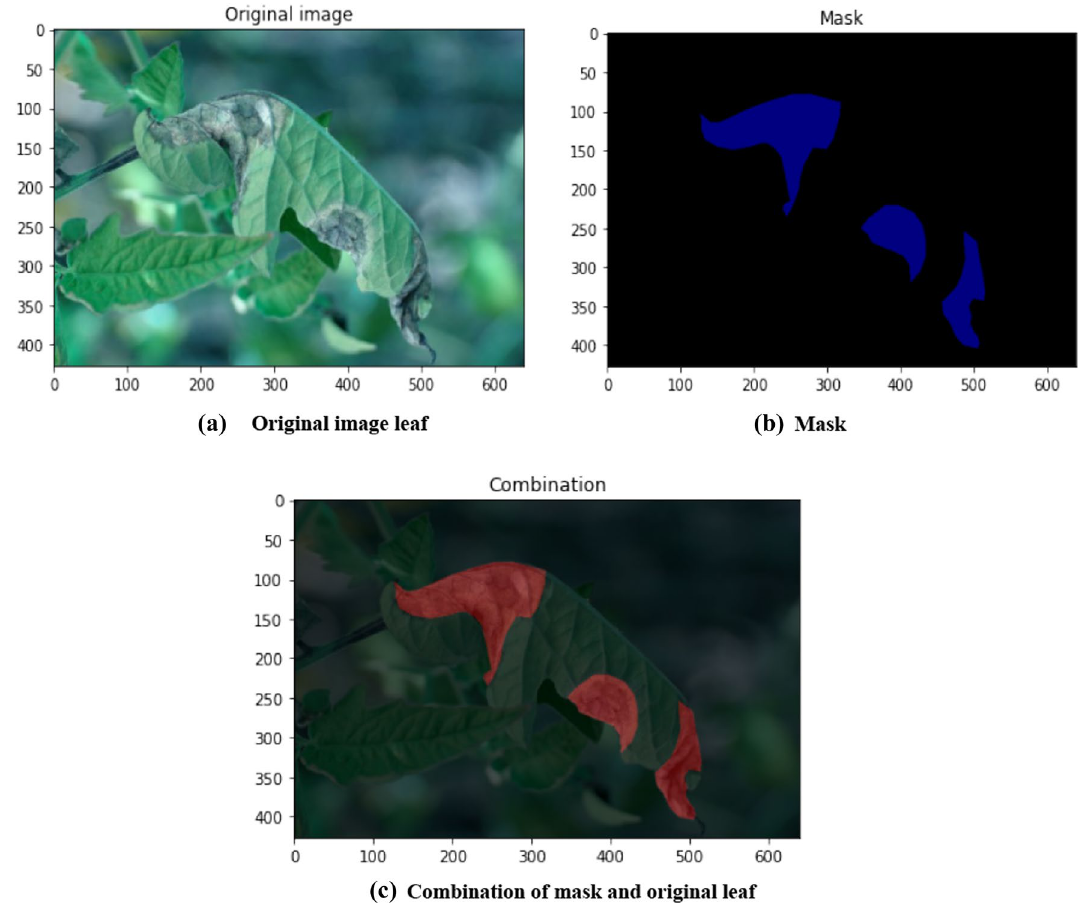
Fig. 14 Samples images in datasets with their mask